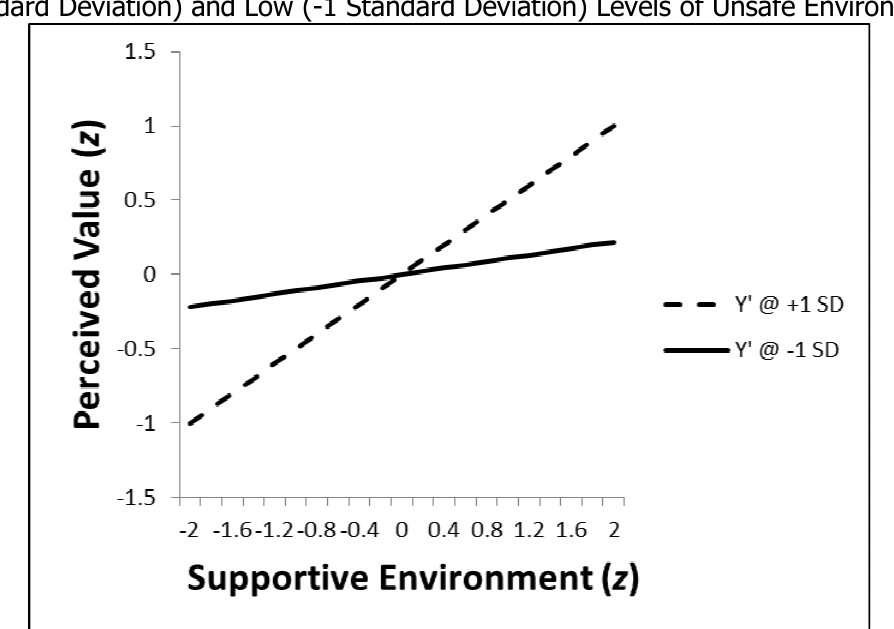
Interaction Effect: Regression of Perceived Value on Supportive Environment at High (+1 Standard Deviation) and Low (-1 Standard Deviation) Levels of Unsafe